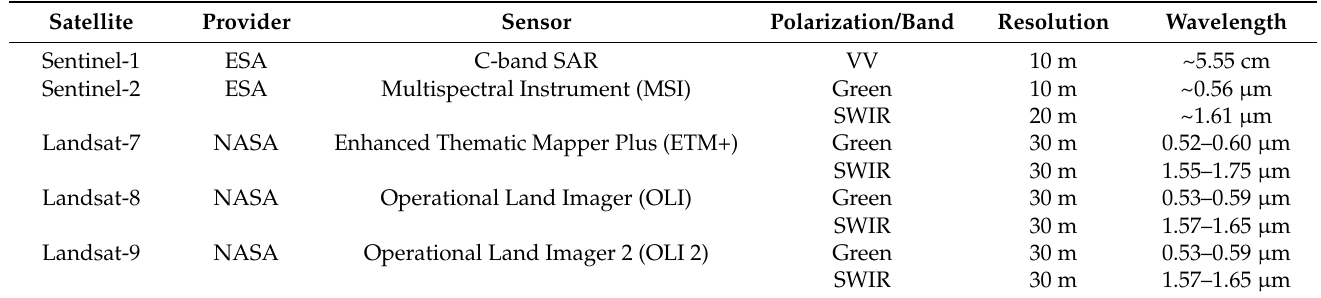
Table 1. Characters of the satellite images used in this study.